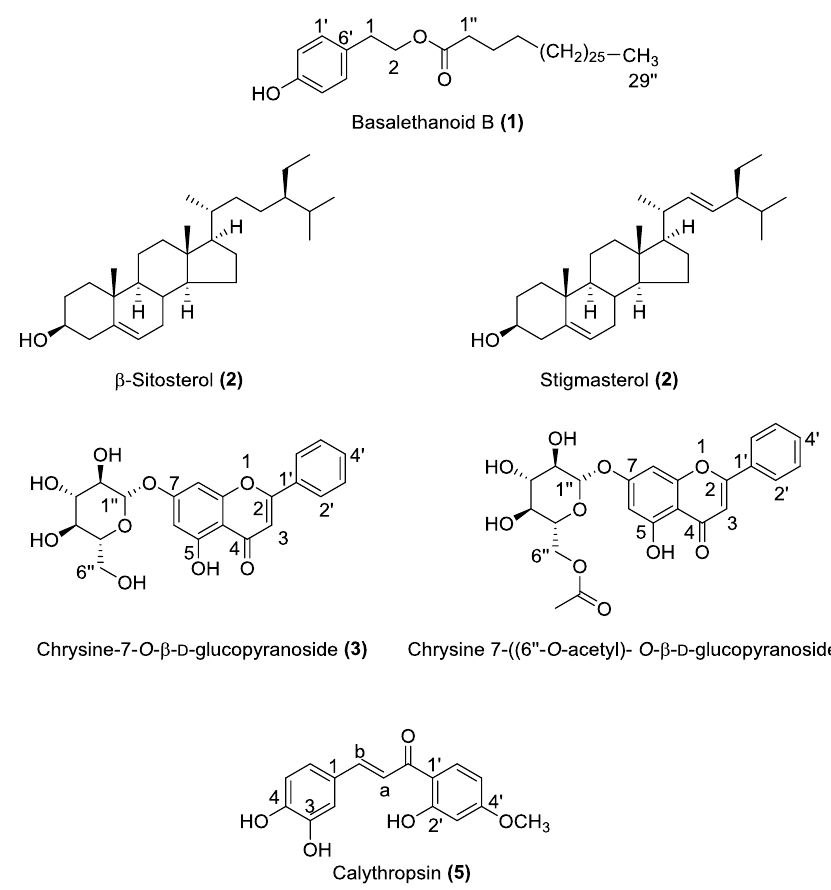
Figure 1. Chemical structures of compounds 1 – 5 isolated from the dichloromethane and methanol extracts of C. villosa stems.